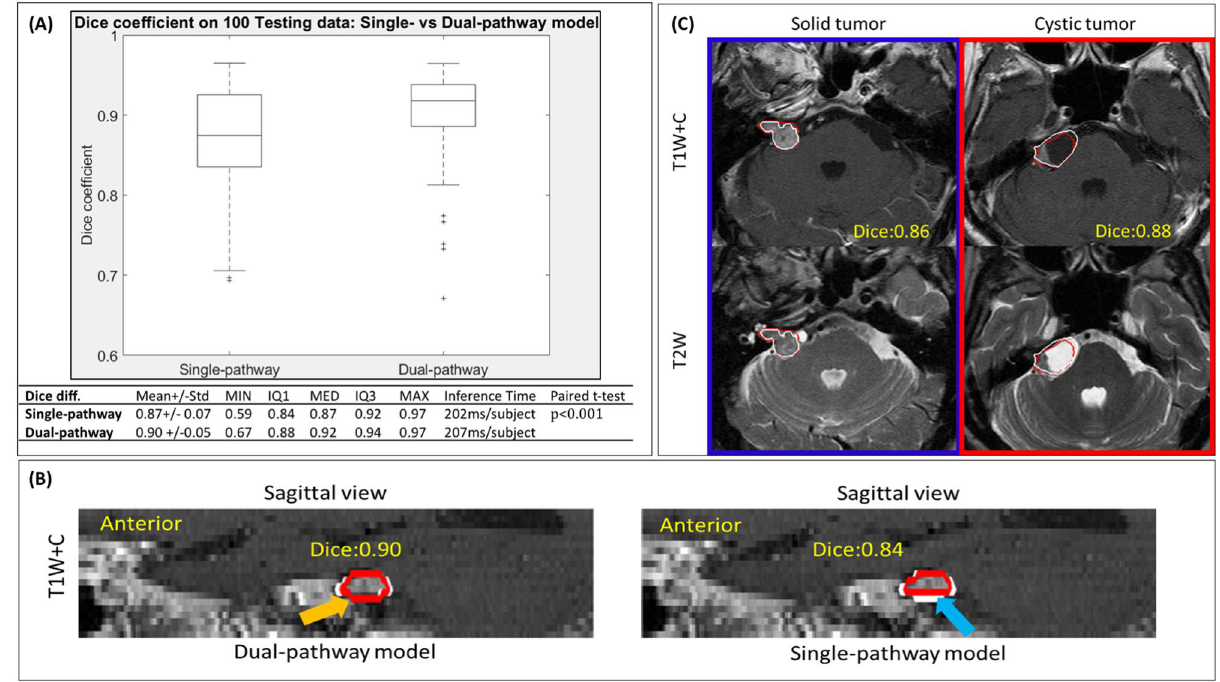
Figure 1. ( A ) Box plots showing dice scores for single-pathway model and dual-pathway model applied to 100 testing data sets (both models trained using T1W+C, and T2W images with Mean: average, Std: standard deviation, MIN: minimum, IQ1: 25th interquartile, IQ3: 75th interquartile, MED: median, MAX: maximum); ( B ) white ground-truth contour on left overlapping red contours predicted for a solid tumor using proposed dual-pathway model (dice score: 0.90); white ground-truth contour on right overlapping red contours predicted for same solid tumor using single-pathway model (dice score: 0.84); ( C ) upper and lower panels respectively display T1W+C and T2W images, where blue and red boxes respectively present testing results from cases of solid tumor and cystic